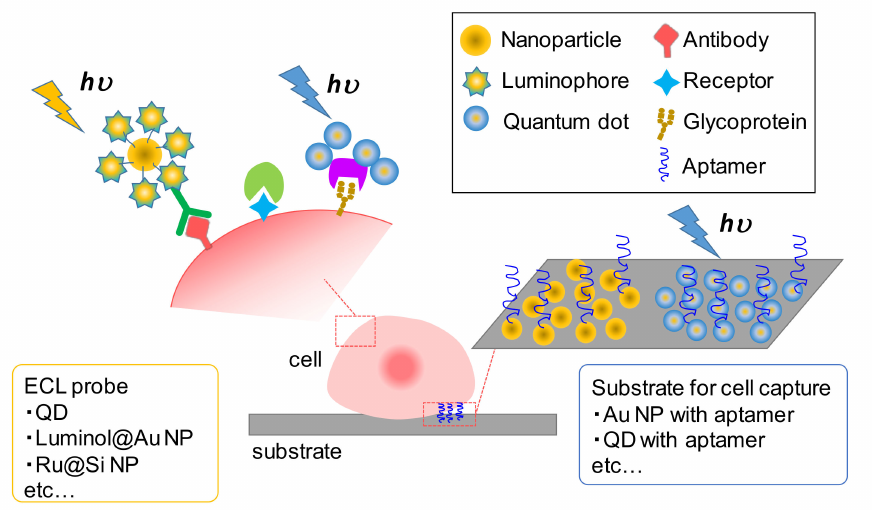
Figure 5. Conceptual image of cytosensing by the ECL technique. The choice of ECL probes and substrates for cell capture varies among di ff erent kinds of nanomaterials and their